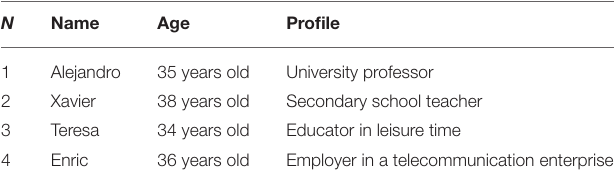
TABLE 1 | Participants’